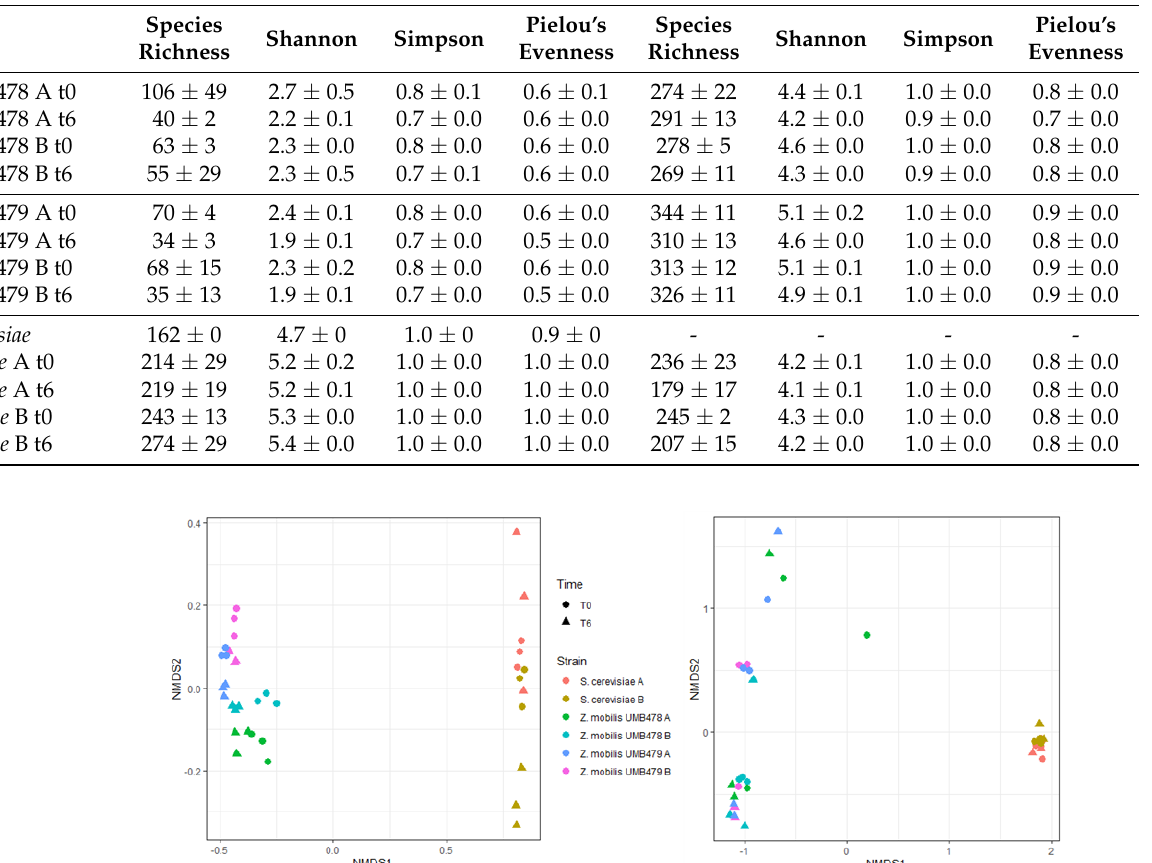
Figure 4. Non-metric multidimensional scaling (NMDS) of fungal ( left ) and bacterial ( right ) com- munities based on Bray-Curtis dissimilarities.